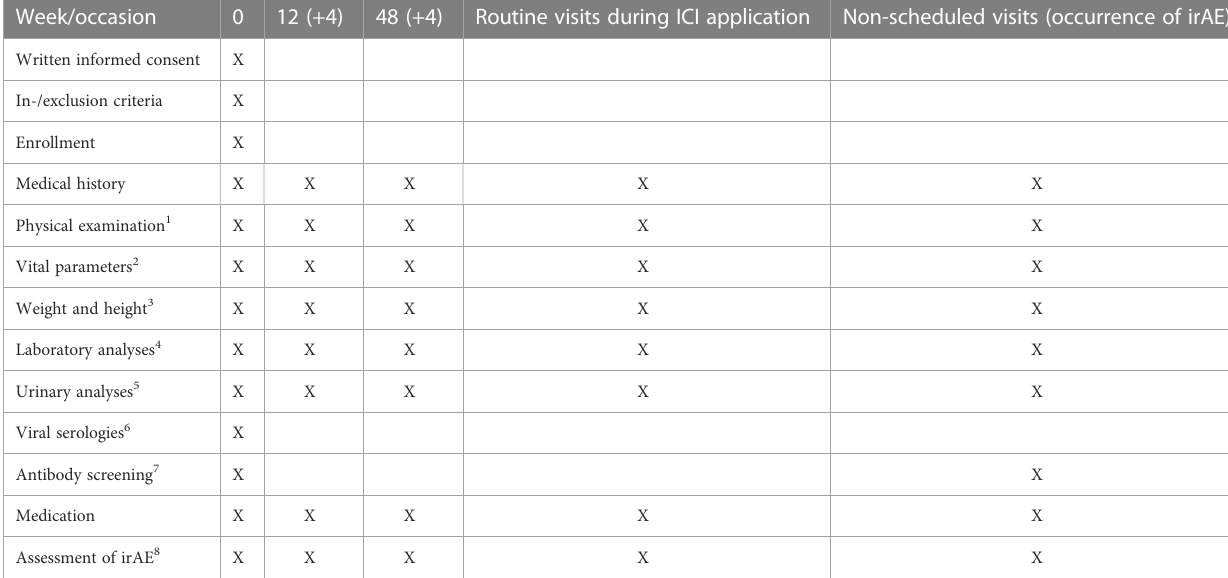
TABLE 1 Schedule of patient visits and